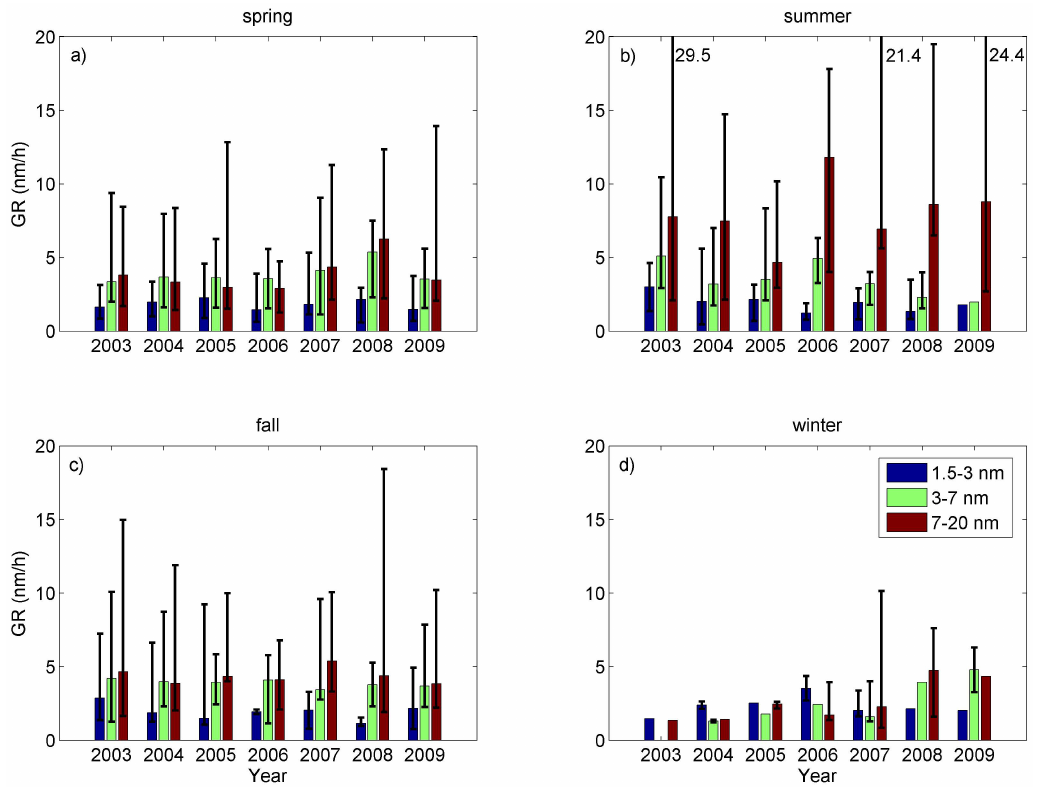
Fig. 3. Median growth rates during (a) spring (March, April, May), (b) summer (June, July, August), (c) fall (September, October, November) and (d) winter (January, February, December) in years 2003–2009 for the three size ranges 1.5–3nm, 3–7nm and 7–20nm. The whiskers represent the 10th and 90th percentiles.